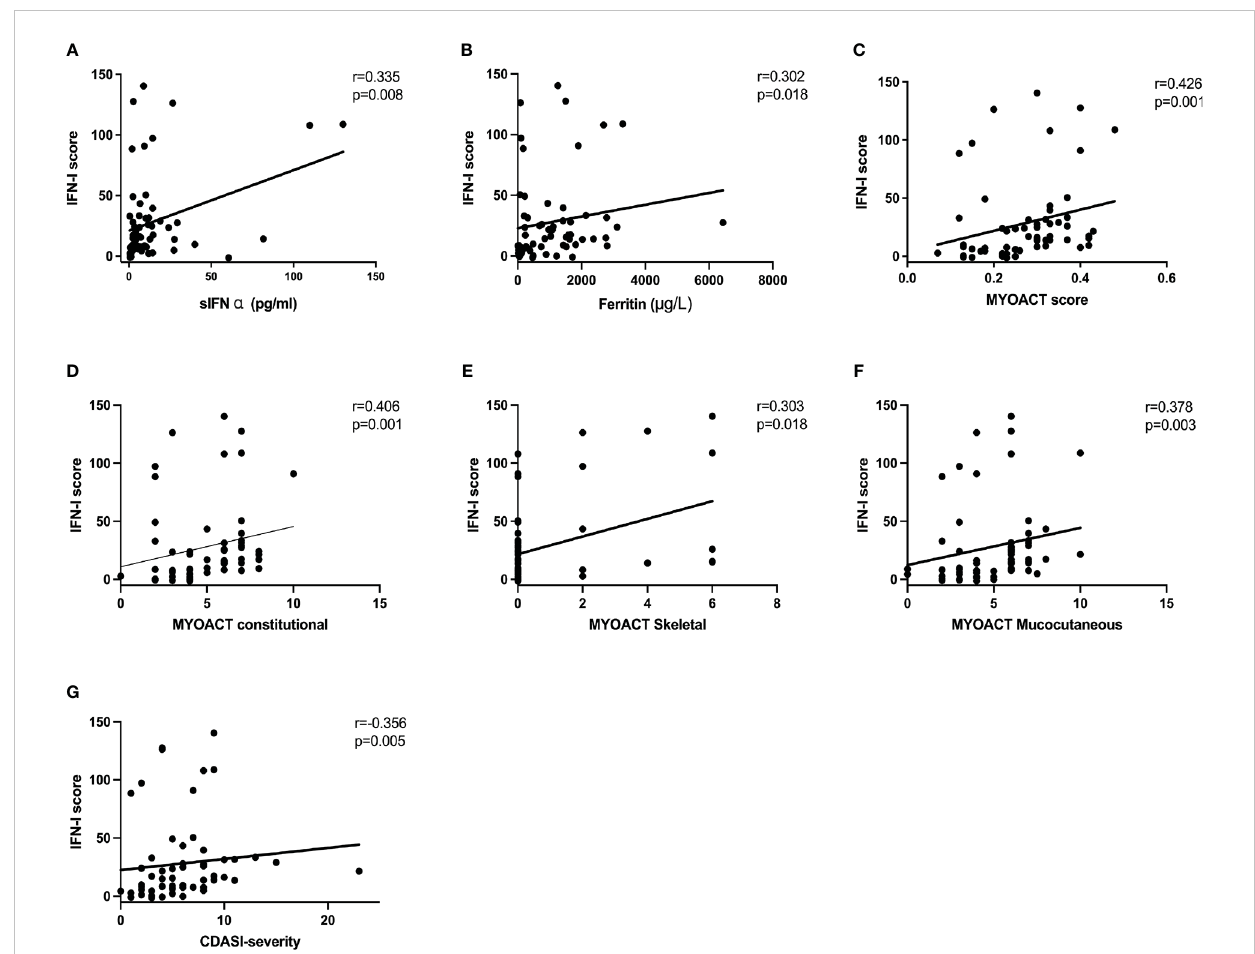
FIGURE 4 Correlation of the IFN-I score with disease activity parameters and clinical features. The IFN-I score in patients with anti-MDA5+ DM is associated with the concentrations of serum IFN- a (A) and ferritin (B) . The IFN-I score also correlated with the MYOACT score (C) , MYOACT constitutional (D) , MYOACT skeletal (E) , MYOACT mucocutaneous (F) , and severity based on the CDASI (G) . The data were analyzed using Spearman ’ s Rho.CDASI, cutaneous dermatomyositis disease area and severity index; MYOACT, Myositis Disease Activity Assessment Visual Analogue